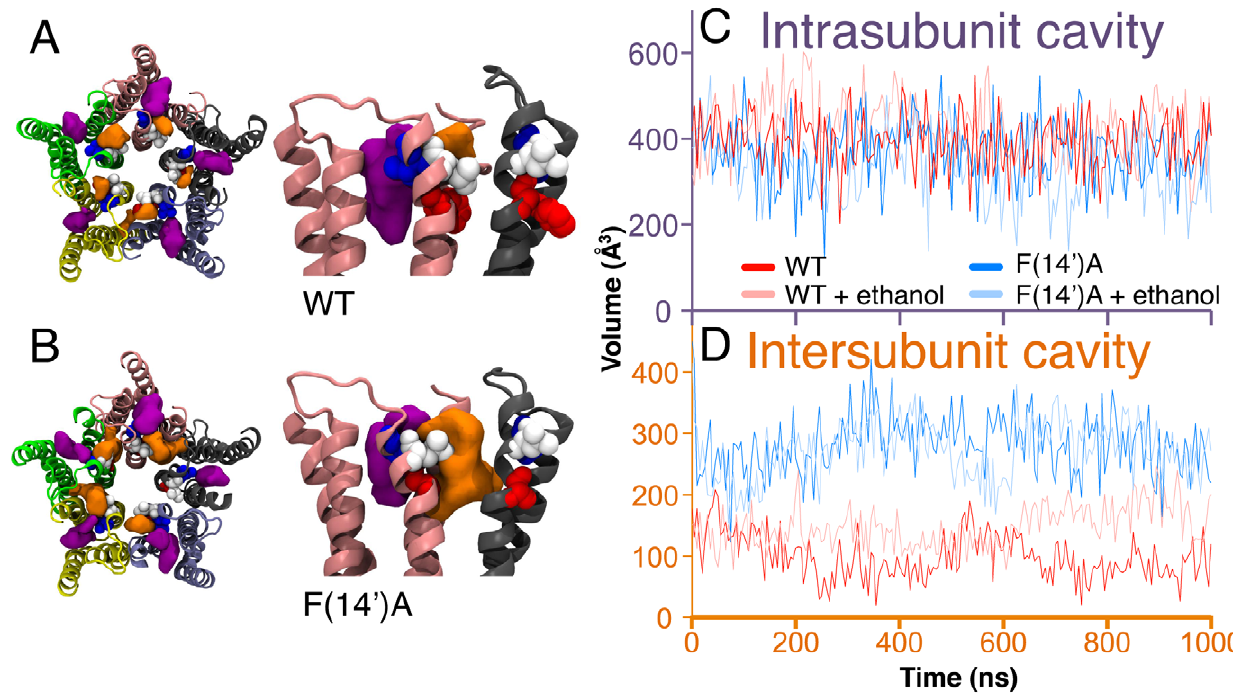
Figure 3. Effects of the F(14 9 )A mutation on the cavity volume. Structures of the WT ( A ) and F(14 9 )A ( B ) TMDs superposed with their intra- subunit and inter-subunit cavities averaged over 1 m s. Views from the extracellular side ( left ) and membrane plane ( right ) display the TMD colored by subunit. Positions 14 9 , 17 9 , and 18 9 are represented as red, white, and blue spheres, respectively. The average intra- and inter-subunit cavities are represented by violet and orange surfaces. ( C ) Intra-subunit and ( D ) inter-subunit cavity volumes averaged across five subunits in the WT (dark red), F(14 9 )A (dark blue), WT + ethanol (light red), and F(14 9 )A + ethanol (light blue) simulations.